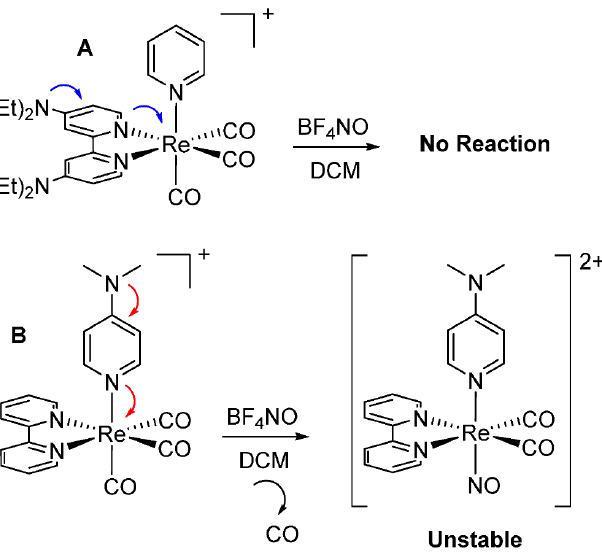
Figure 5. Molecular possibilities ( A , B ) envisioned to stabilize the fac -[Re(CO) 2 (NO)] 2+ core via EDS on N-N and monodentate py ligand and reactions of corresponding tricabonyl complexes with NO + .